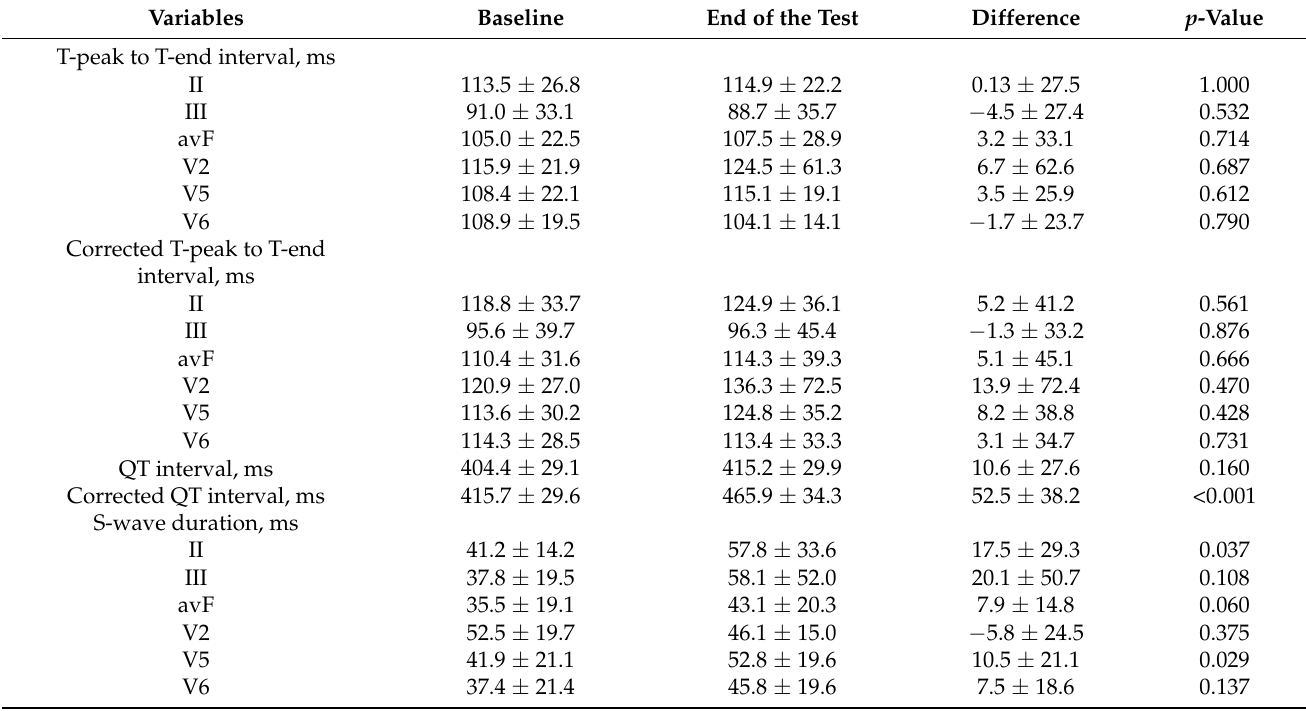
Table 3. Electrocardiographic parameters at baseline and end of the test.